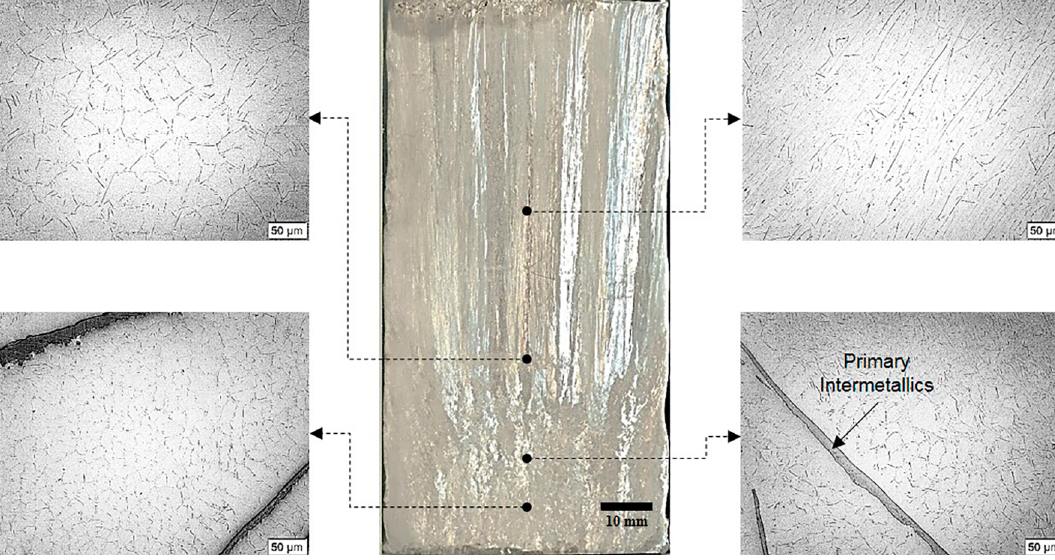
Sn-Ni alloy the equilibrium microstructure is formed by the β-Sn+Ni Sn mixture. However, the growth of β-Sn 3 4 cells and intermetallic particles appears to prevail in all Sn-Ni alloys samples, despite the presence of primary intermetallics for the Sn-0.5wt.%Ni